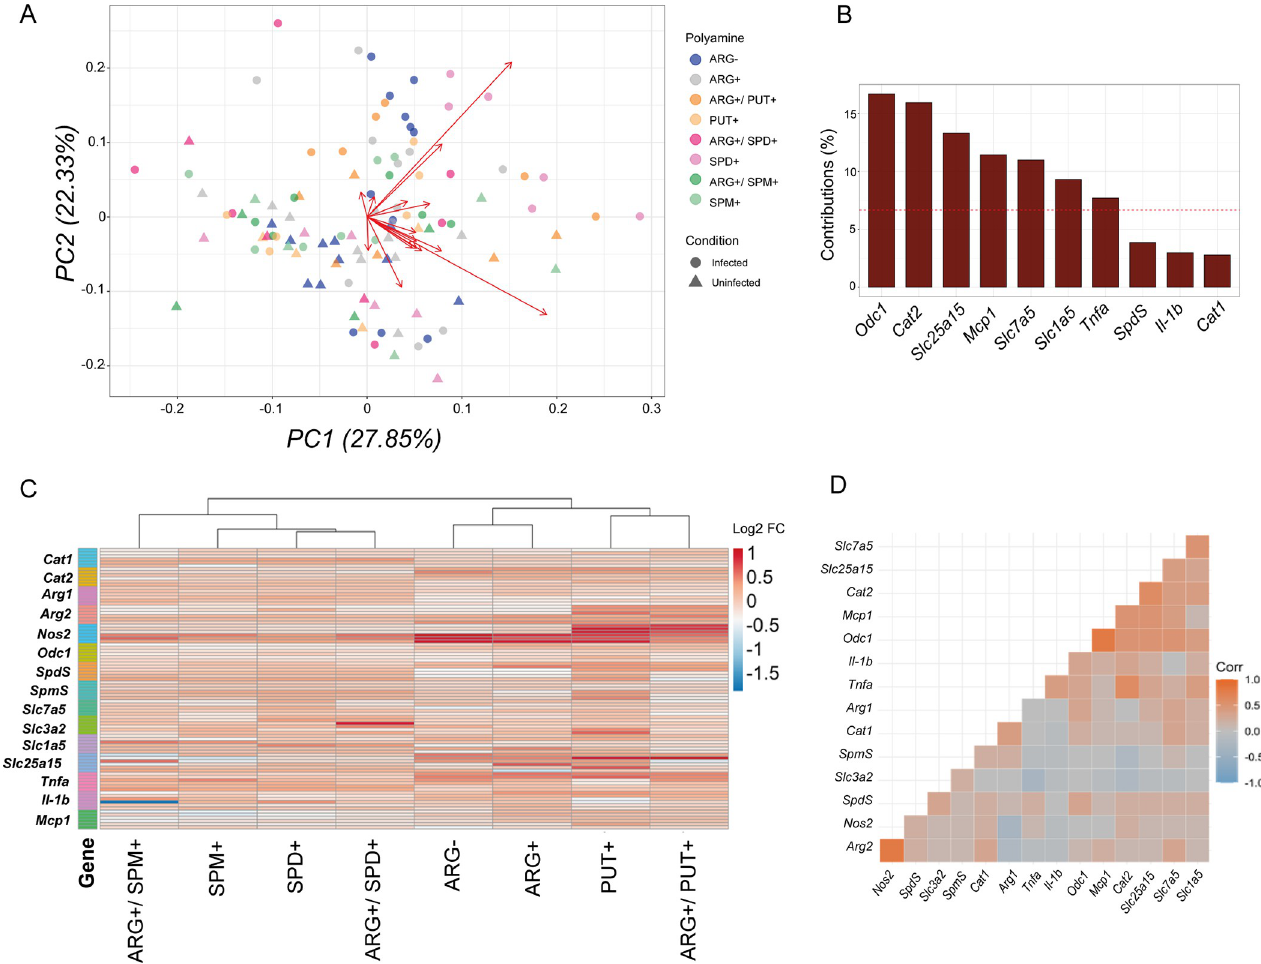
Fig 5. Correlation and heat map analysis. (A) PCA analysis of gene expression variance in all conditions analyzed after 4h in infected and non-infected macrophages and (B) percentage of contributions of each gene to the Principal Component 1 (PC1). (C) The Heat Map analysis of the Log2-fold change of genes upregulated (red) and downregulated (blue) and (D) gene expression correlation matrix (Spearman correlation) showed positive (orange) and negative (blue) associations between gene expression from data of macrophages supplemented with putrescine (put+), spermidine (spd+), spermine (spm+) with or without L-arginine (arg+) concomitant or not to L . amazonensis infection for